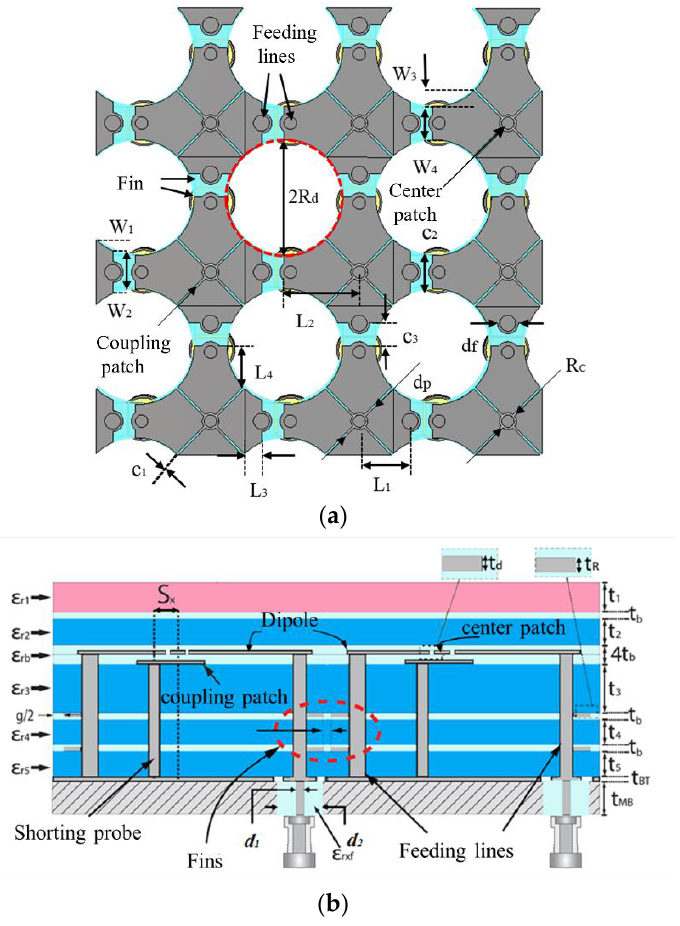
Figure 2. Schematic of the proposed PUMA array. ( a ) top view; ( b ) diagonal cross-sectional view . Table 1. PUMA Array Structure Parameters and Dimensions.